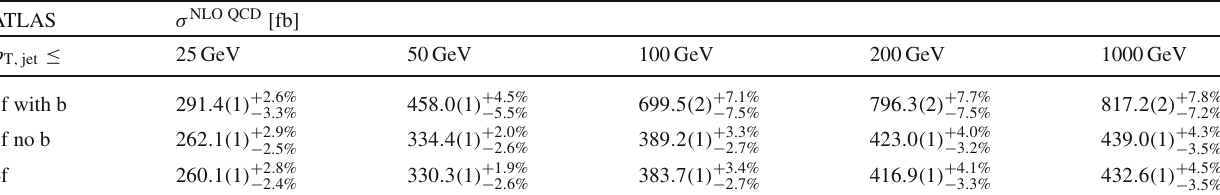
Table 2 Integrated cross section at NLO QCD for the process pp → values of the jet veto. The results in the third line (5f with b) are com- puted using the 5-flavour PDF set NNPDF23_nlo_as_0118_qed